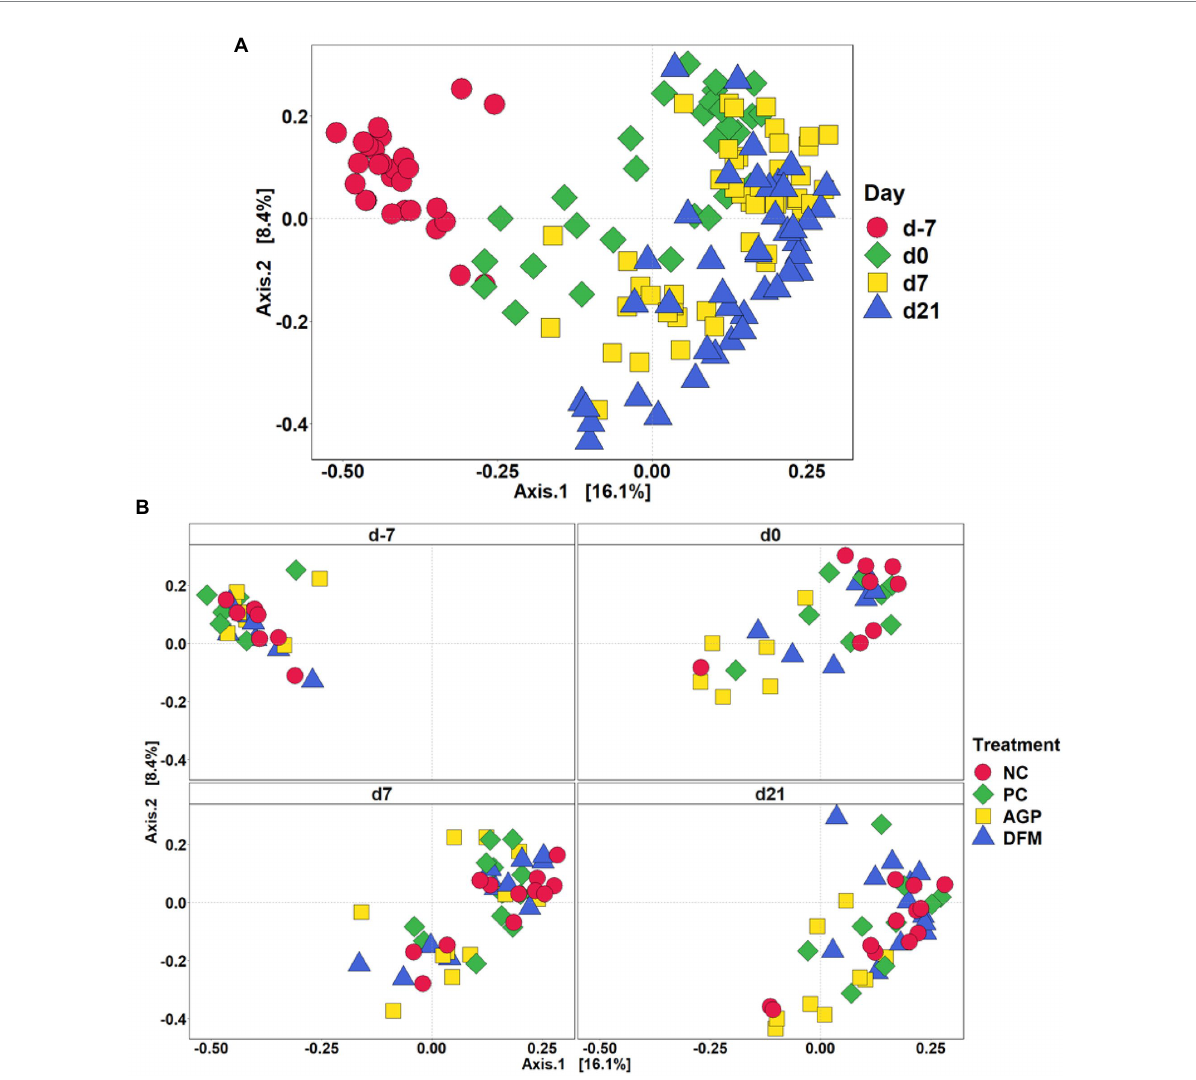
FIGURE 2 Beta diversity of fecal microbiota in enterotoxigenic E. coli F18 challenged pigs at the beginning of the experiment, on day 0 before inoculation, on day 7 and 21 post-inoculation by day (A) and treatment (B) . Data were analyzed by principal coordinate analysis (PCoA) based on the Bray–Curtis dissimilarity. NC = negative control, PC = positive control, AGP = antibiotics, DFM = B. subtilis . Each mean represents 7 observations on day − 7 and each mean represents 9–12 observations on day 0 and day 7 and 21